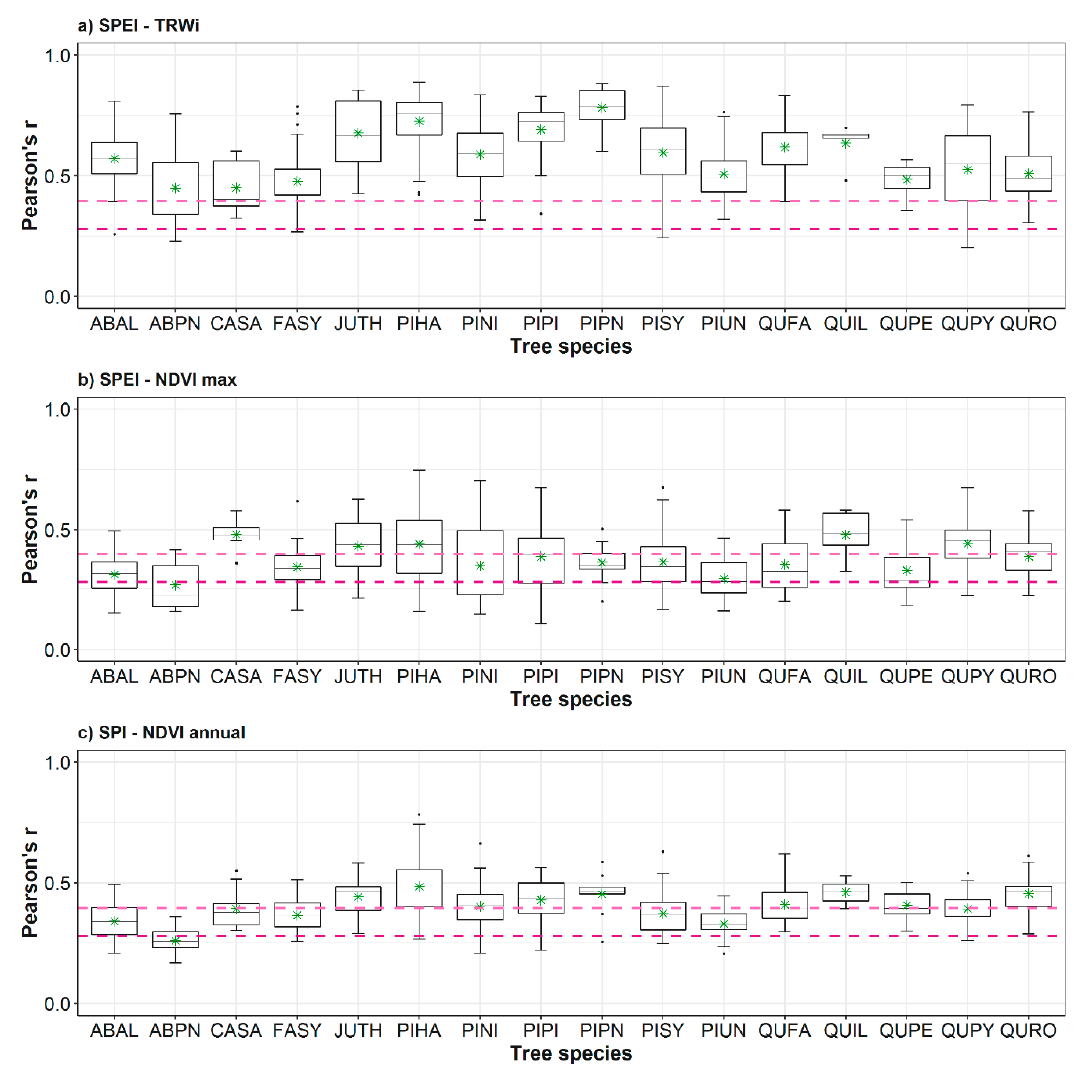
Figure 5. Box plots showing maximum Pearson correlation coefficients computed between ring-width indices (TRWi, ( a )), NDVI max ( b ), NDVI annual ( c ), and the most correlated drought index for each tree species. The solid black line corresponds to the median, green asterisks mark the mean and dashed lines show the significance level at p < 0.05 (light pink) and p < 0.01 (dark pink). Species’ codes correspond to those listed in Table 1.